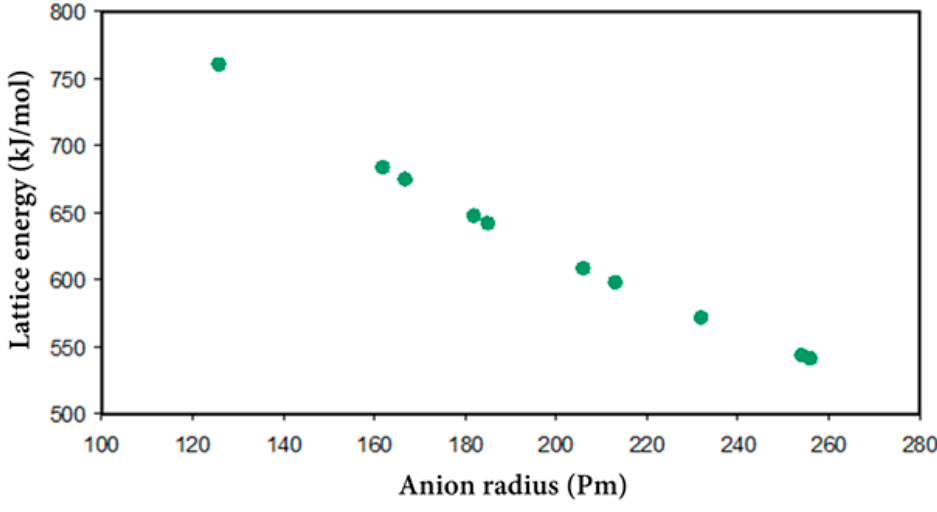
Figure 5. Calculated lattice energy versus anion radius.